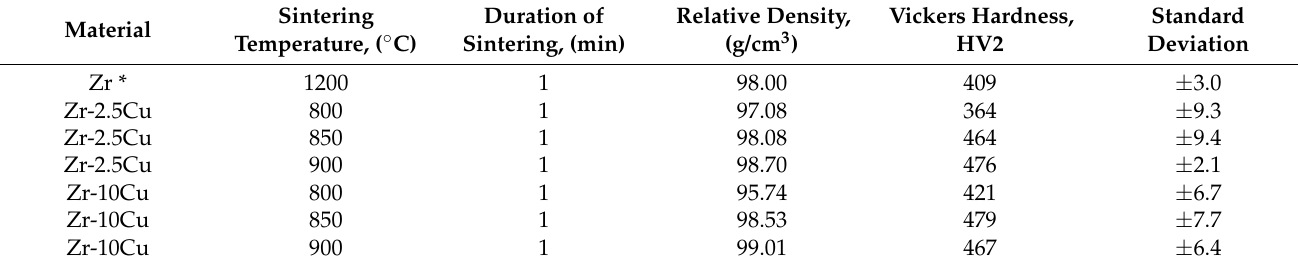
Table 2. Influence of SPS process parameters on the relative densities and hardness values of Zr, Zr-2.5Cu and Zr-10Cu. Sintering Temperature, Material